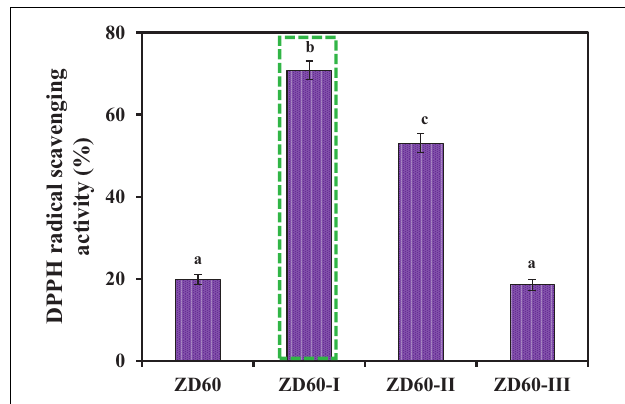
FIGURE 3 | DPPH · scavenging activities of papain hydrolysate of ZD60 and its three subfractions (ZD60-I to ZD60-III) at the concentrations of 10 mg/ml, respectively. All data were presented as the mean ± SD ( n = 3). a − c Values with the different letters indicate a significant difference ( p < 0.05).